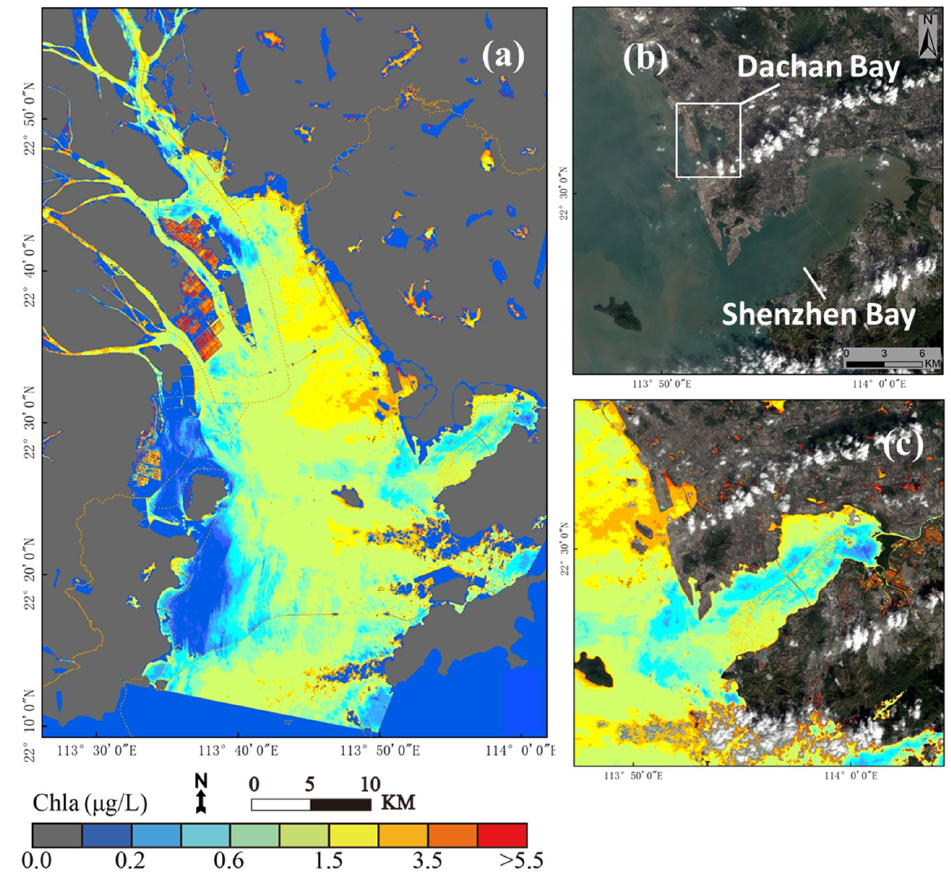
Figure 7. Chlorophyll concentrations in the PRD. ( a ) The entire PRD. ( b ) Dachan Bay and Shenzhen Bay. ( c ) Chlorophyll concentration in Dachan Bay and Shenzhen Bay.